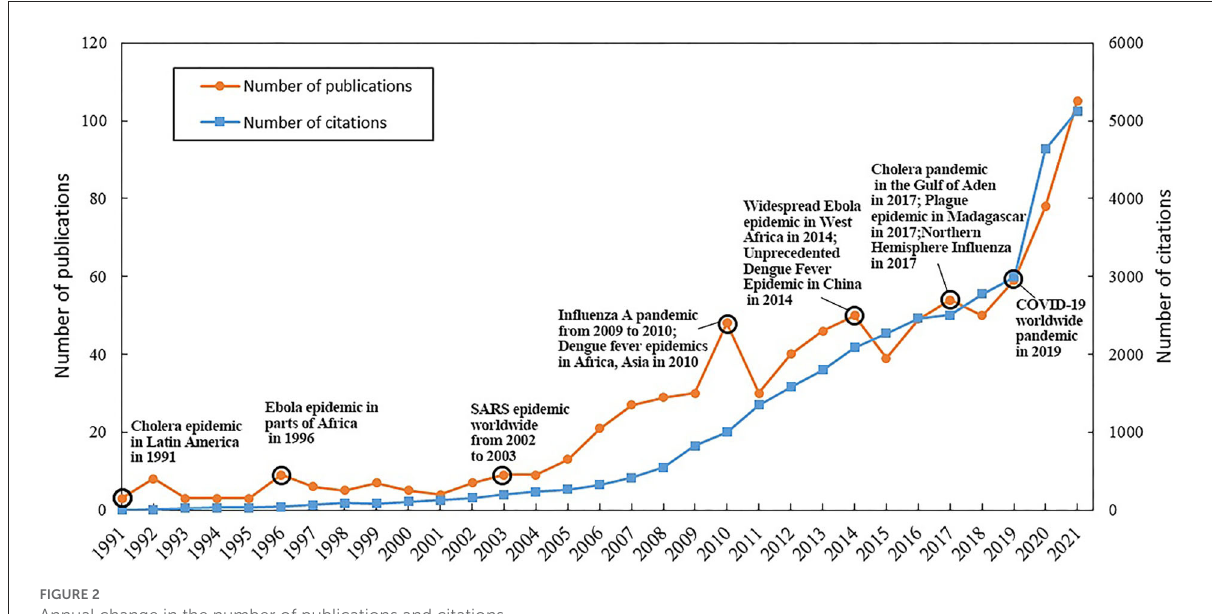
FIGURE2 Annual change in the number of publications and